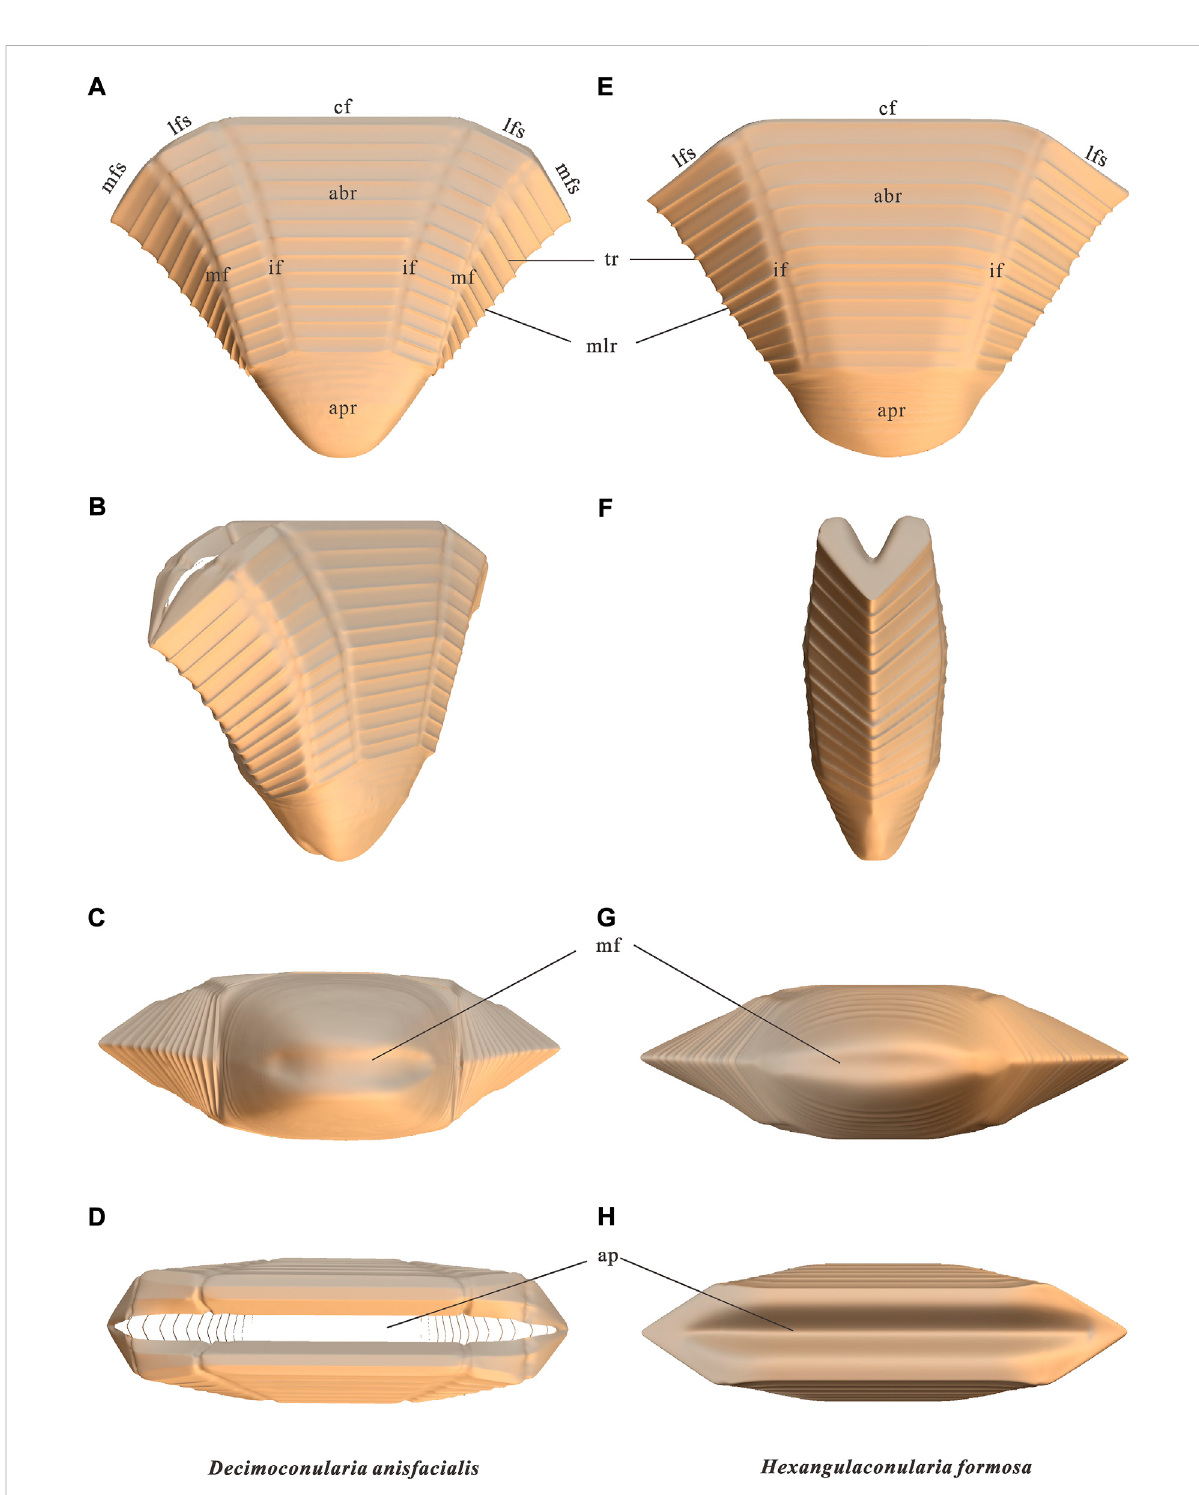
FIGURE 4 Three-dimensional reconstructions of Decimoconularia anisfacialis n. sp. and Hexangulaconularia formosa . (A,E,B,F,C,G,D,H) Side, oblique lateral, apical, and apertural views, respectively. The color of the reconstructions does not represent the actual color of the animals. Abbreviations: abr=abapical region; ap=aperture; apr=apical region; cf=central face; if=interfacial (longitudinal) furrow; lfs=lateral faces; mf=marginal furrow; mfs=marginal faces; mlr=marginal longitudinal ridge; tr=transverse